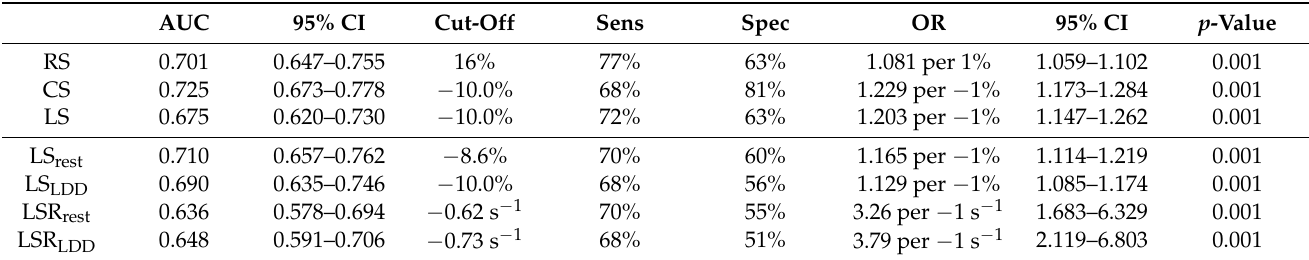
68% 56% 1.129 per − 1%